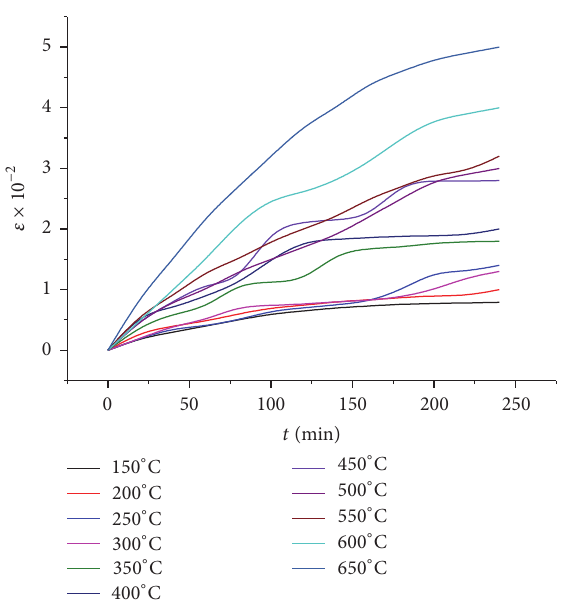
Figure 9: Triaxial creep curves of coal sample between 150 ∘ C and 650 ∘ C.